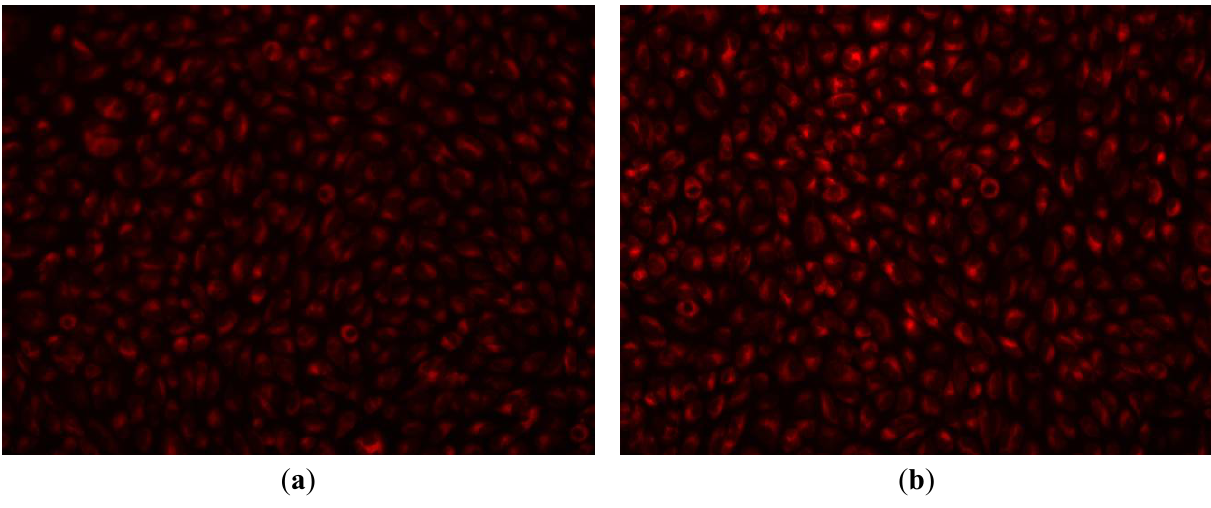
Figure 7. Fluorescence microscopy images of endothelial cells grown in the presence